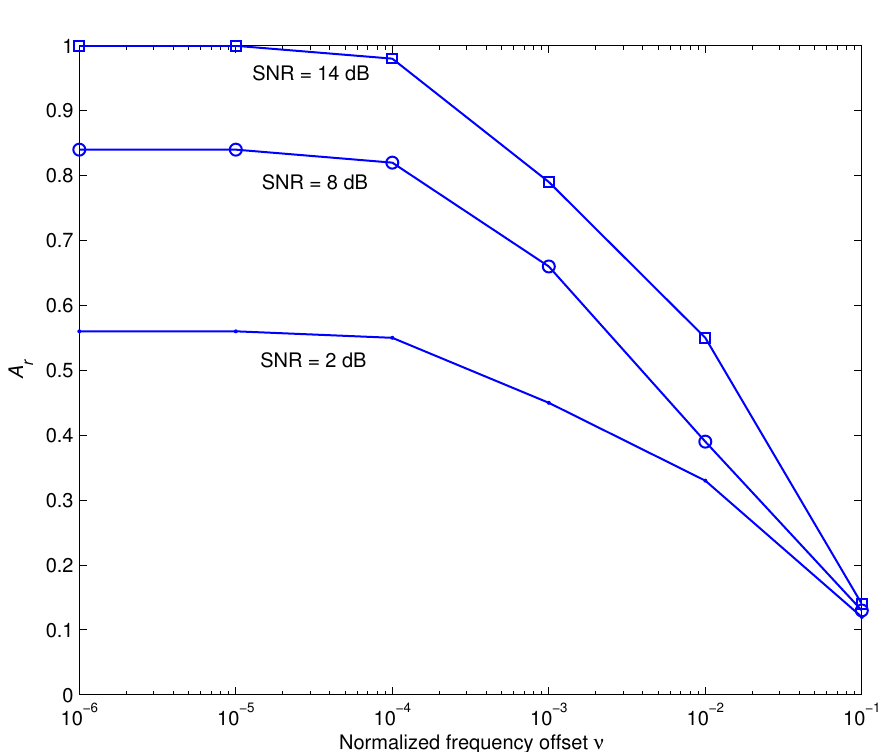
Figure 6. The impact of normalized frequency offset ν on the recognition